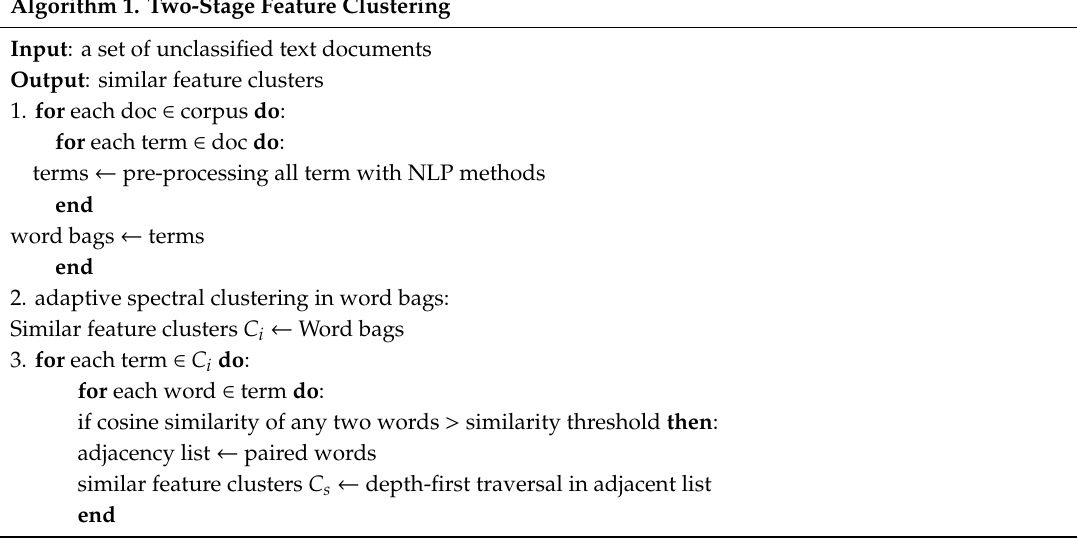
Algorithm 1. Two-Stage Feature